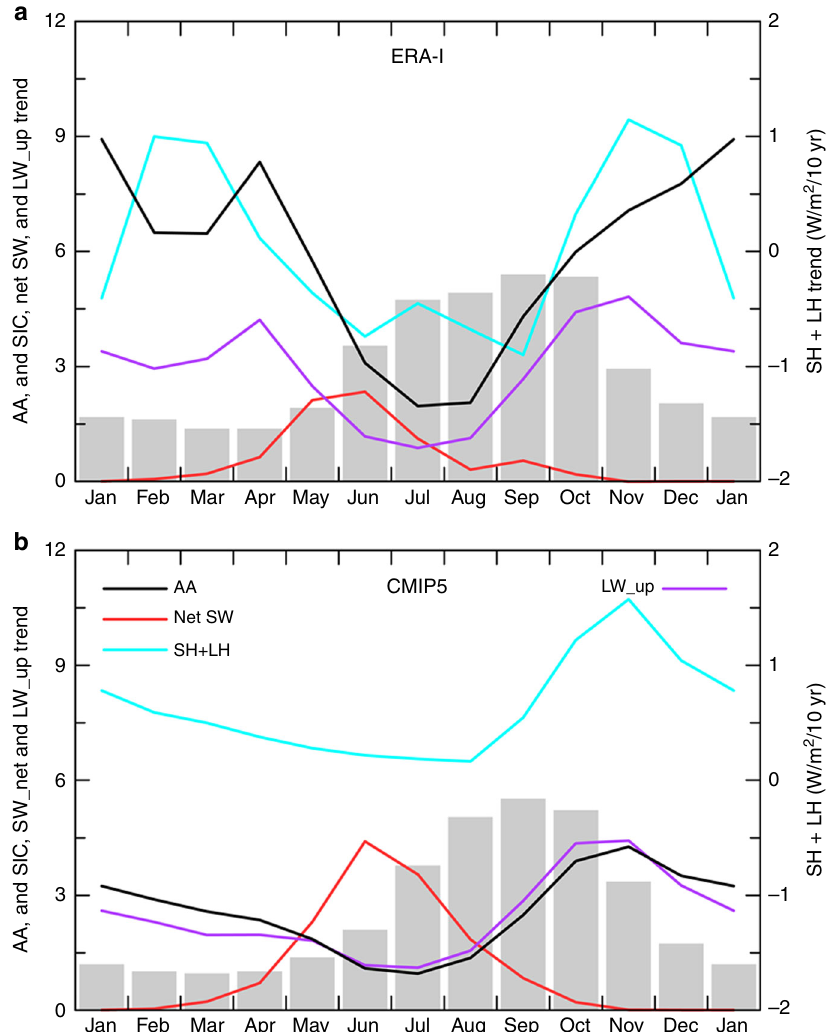
Fig. 1 Seasonality of the historical (1979 – 2016) trends in Arctic (67° – 90°N) sea-ice cover (SIC), Arctic ampli fi cation (AA), and Arctic energy fl uxes. a from ERA-Interim reanalysis data and b from the ensemble mean of historical (for 1979 – 2005) and RCP8.5 (for 2006 – 2016) simulations averaged over 38 CMIP5 models. The SIC trend (gray bars) is in 10 5 km 2 /decade; the AA (black line) is de fi ned as the ratio of the surface air temperature trends between the Arctic and the globe; the surface net shortwave (red, positive downward), sensible plus latent heat (blue, positive upward) and upward longwave (magenta) fl ux trends are in W/m 2